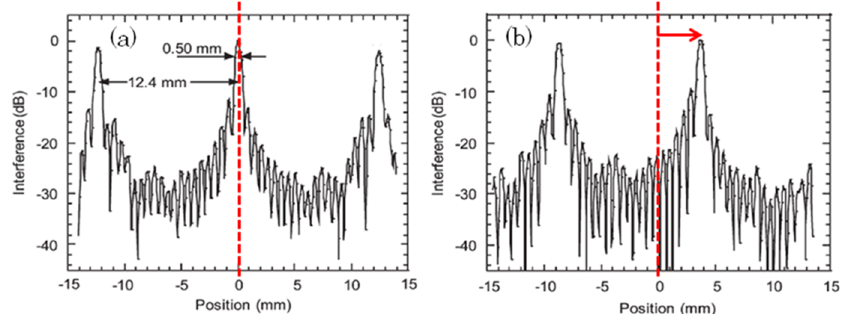
Figure 7. Parallel shift of the synthesized optical coherence function by using phase modulation, which has a similar waveform to the FM waveform [22]. Figure 7a shows a synthesized delta-function-like optical coherence function without the shift along the position axes, and Figure 7b shows that shifted by the phase modulation, respectively.